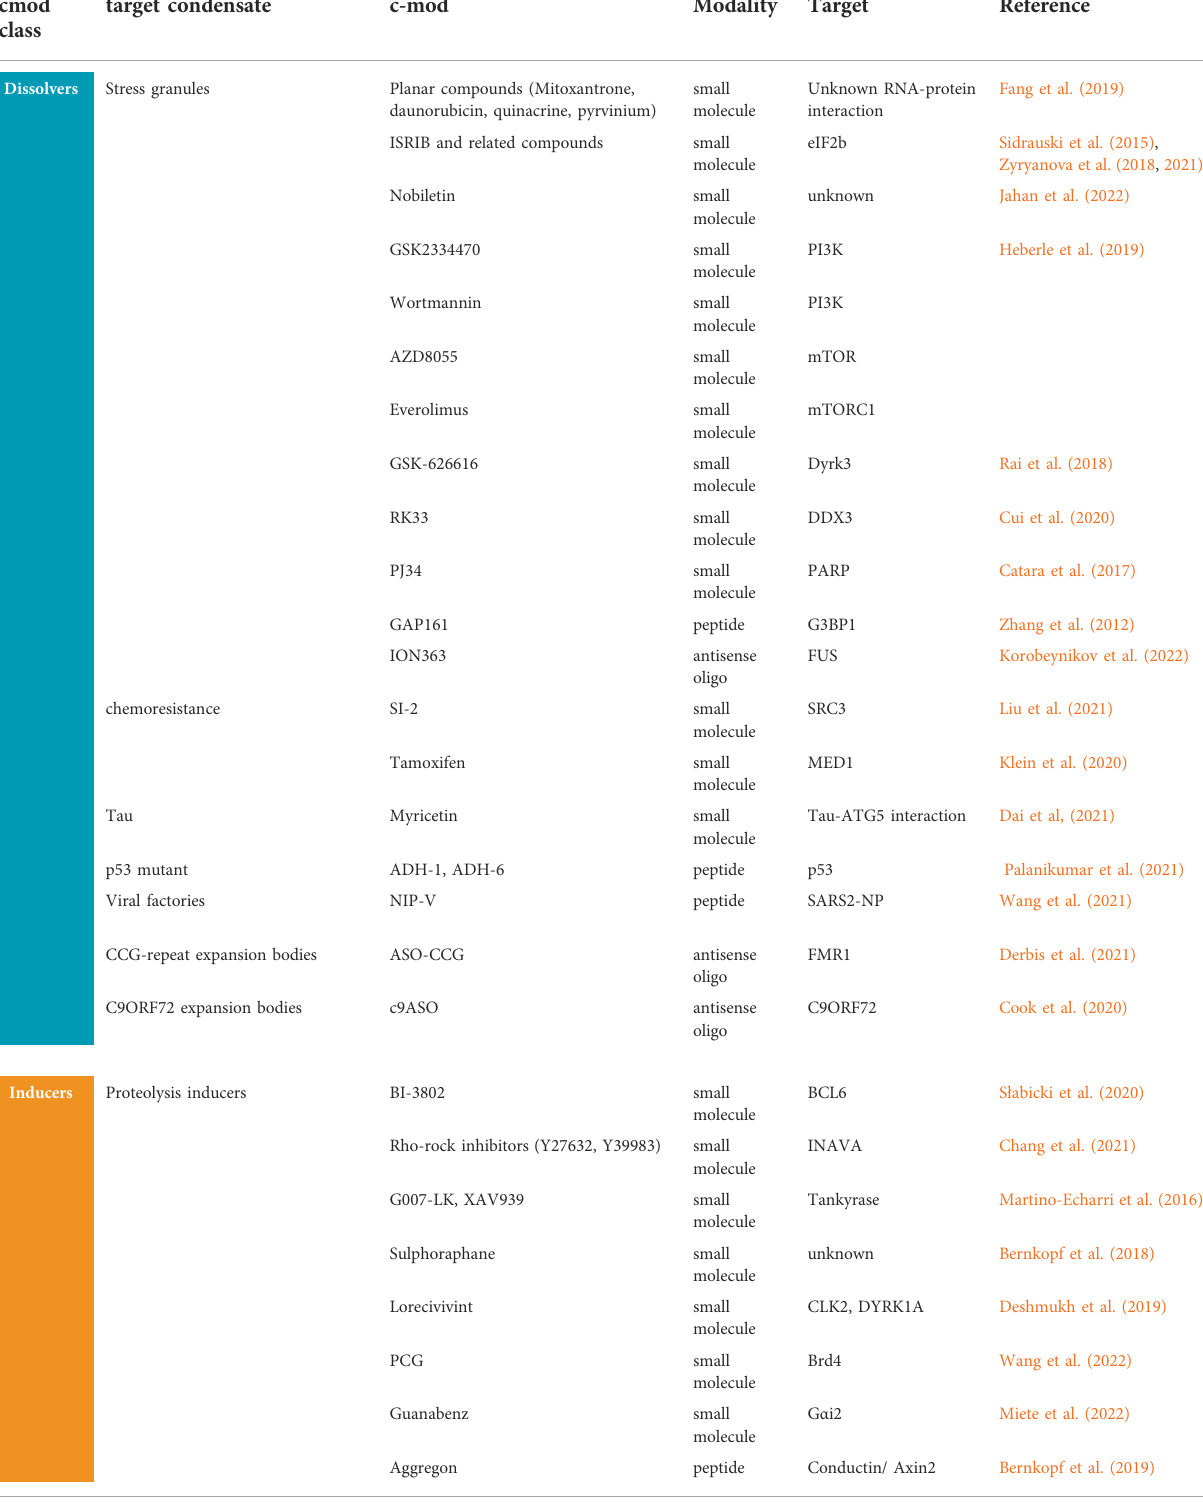
TABLE 1 c-mod therapeutic modalities. A table collating the different classes of c-mods (dissolvers, inducers, localizers, and morphers), the condensate target, the representative chemical modality (small molecule, peptide, anti-sense oligo), the molecular target (if reported in the study) and the reference of the study that reported the observation that is reminiscent of a condensate modi fi